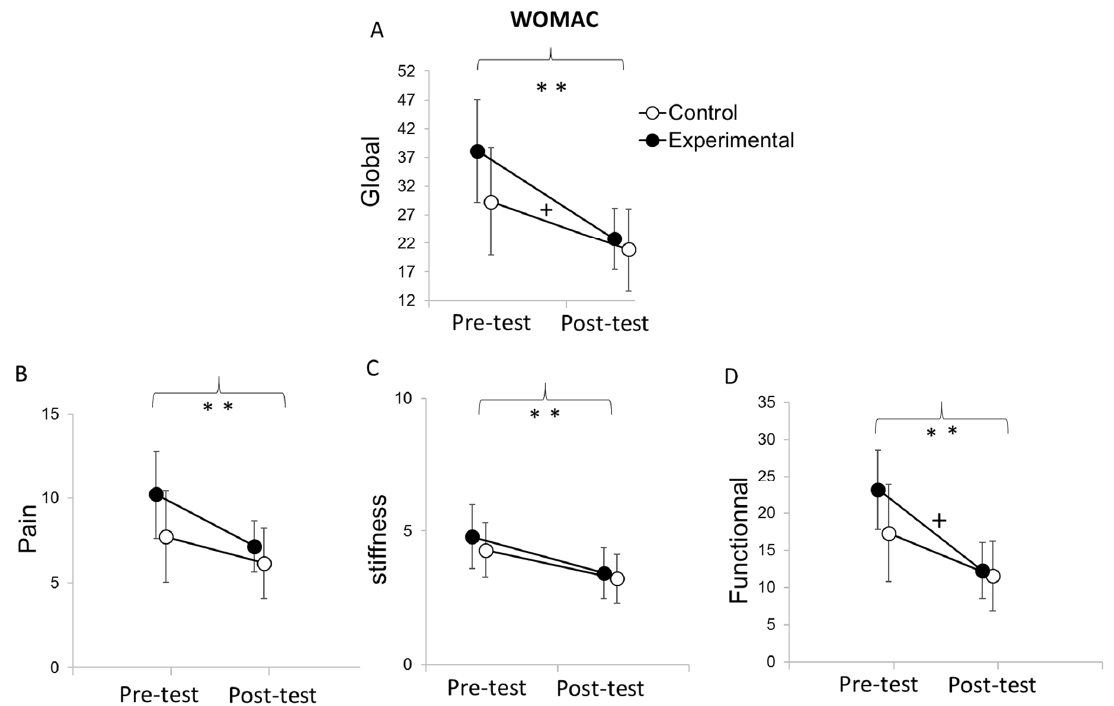
Figure 6. Mean results of WOMAC scores for pre-test and post-test and for the control and the experimental groups ( A – D ). Error bars represent confidence interval at 95%. ** indicates an effect at the moment of the evaluation at p < 0.001. + indicates an interaction between the moment of the evaluation and the condition at p < 0.05. Pre-test indicates the level of performance at 0 weeks (before the rehabilitation program), and post-test indicates the level of performance at 3 weeks (at the end of the rehabilitation